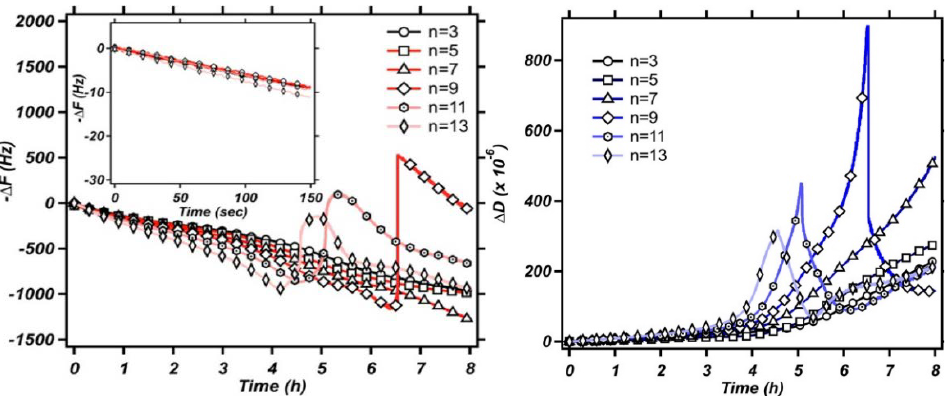
Figure 20. An example of a film resonance. At some point, the frequency jumps, as discussed in the caption to Figure 19. Reprinted with permission from [96]. Copyright 2017 American Chemical Society. These experiments occurred in liquid. Film resonances can occur in liquids, as well, because Equation (49) also contains terms of the form tan